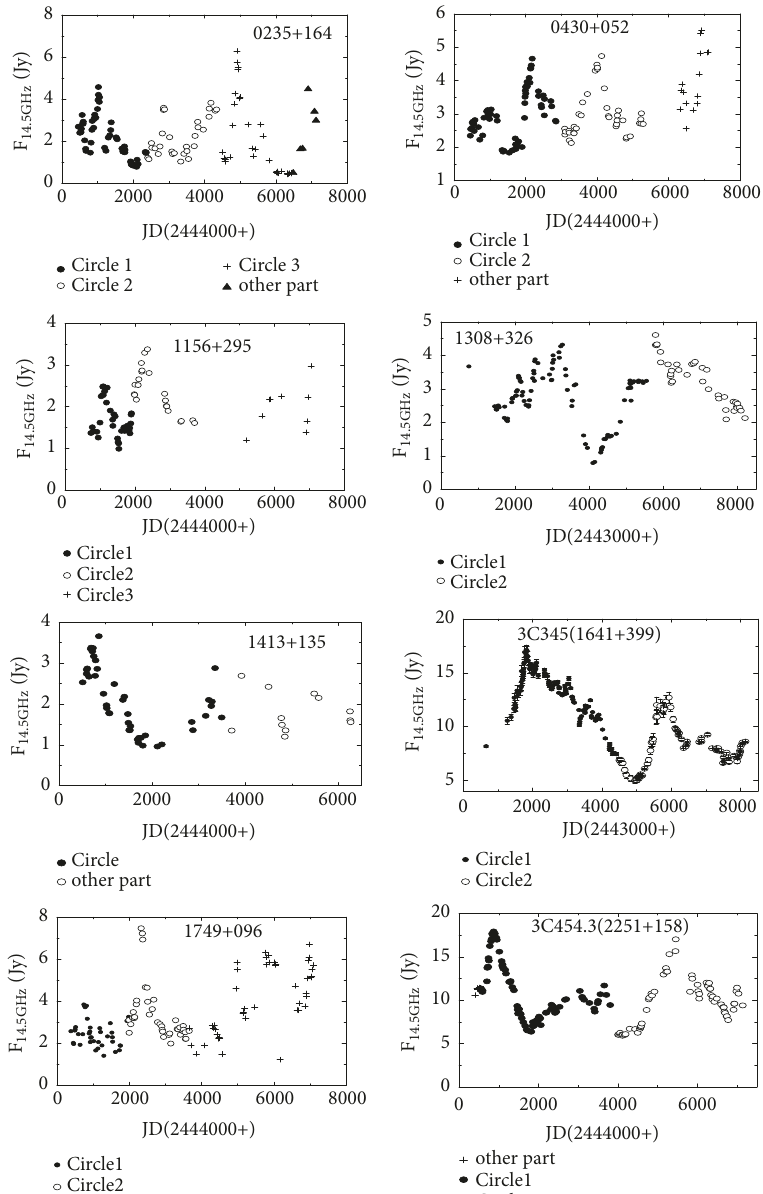
Figure 4: For each source, based on the time interval of elliptic circles, the light curves can be divided into different parts.